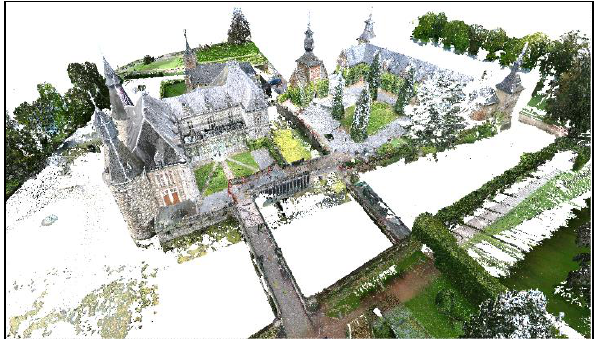
Figure 1. Point cloud of Jehay castle with approximately 3 billion points.